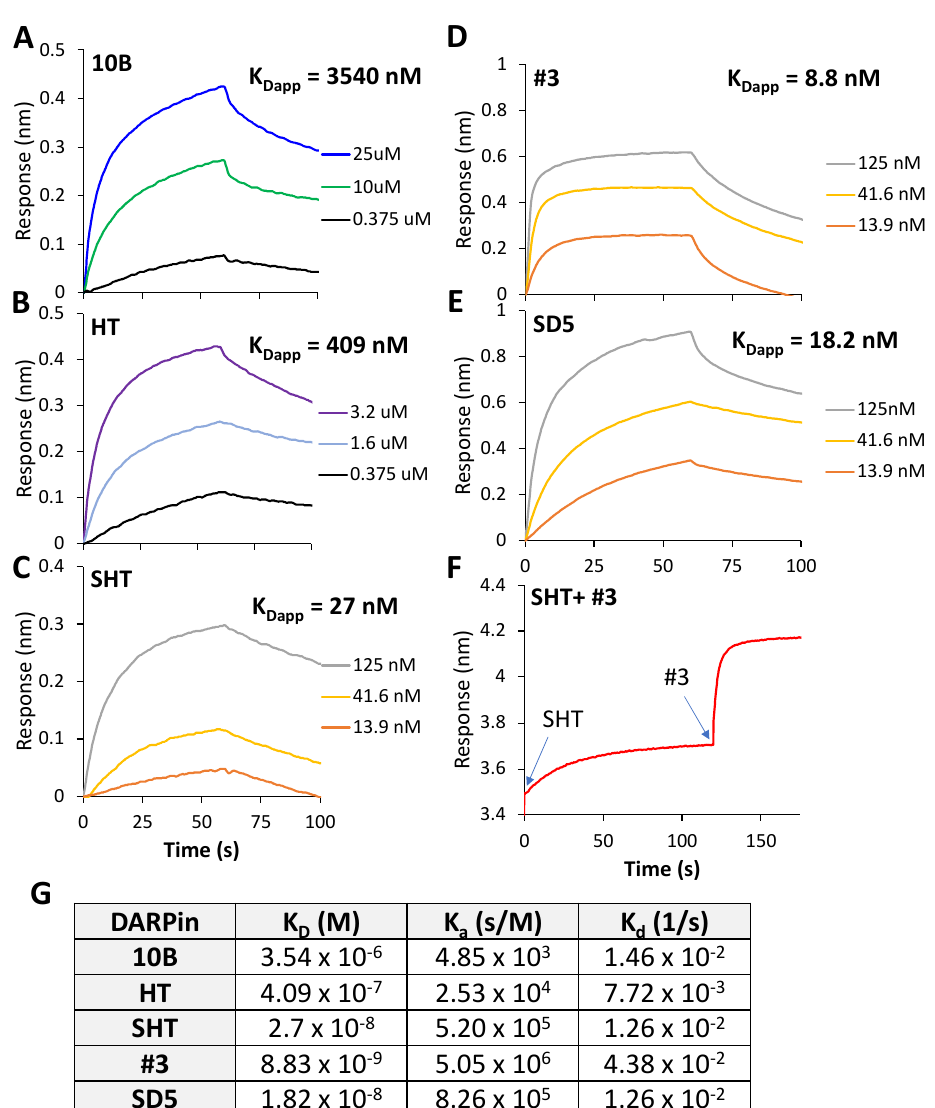
Figure 6. Binding kinetics of selected DARPins. ( A – E ) Sensorgrams of the various DARPins under equilibrium binding condition. ( F ) Sensorgram of a sequential binding experiment in which the biosensor was first loaded with DARPin SHT (125 nM) for 120 s to reach saturation. The sensor was then dipped into a buffer containing DARPin #3 (125 nM) for 30 s to record the binding kinetics. ( G ) Summary of the binding and rate constants. To evaluate the in vivo efficacy, Swiss Webster mice (group of 5) were challenged intraperitoneally with either Stx2a (60 ng per mouse) alone, or with a mixture of Stx2a (60 ng) and DA1-SD5 (5 or 10 mg/kg) on day 0 (Figure 7C). Mice were closely monitored after toxin challenge and were humanely euthanized when they exhibited neurologic signs, became less responsive to stimuli, or lost 20% of their body weight. All mice receiving the toxin alone died within 3 days. On the other hand, all mice receiving the same dose of Stx2a plus 10 mg/kg of DA1-SD5, and 4 out of the 5 mice receiving the toxin and 5 mg/kg of DA1-SD5, survived until the end of the study, with no clinical signs of disease. These data offer an encouraging assessment of the in vivo efficacy of our engineered